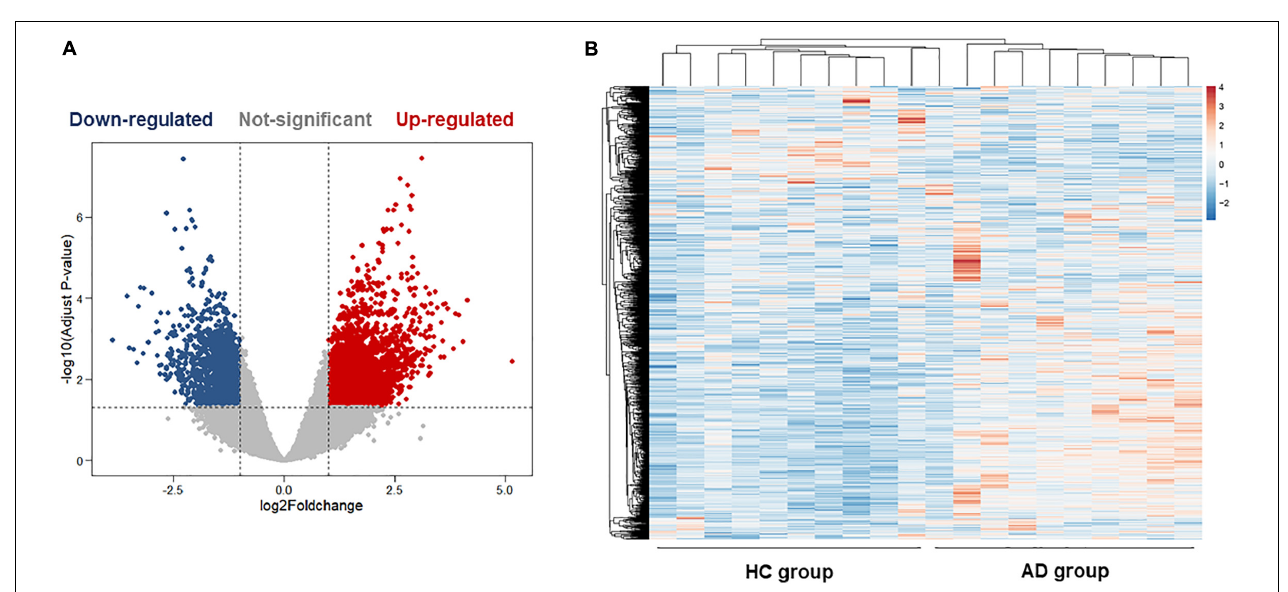
FIGURE 1 | Prediction of the quercetin target genes. (A) The chemical structure of the quercetin. (B) The classification of drug target genes according to their biochemical criteria. Different colors indicate different items.